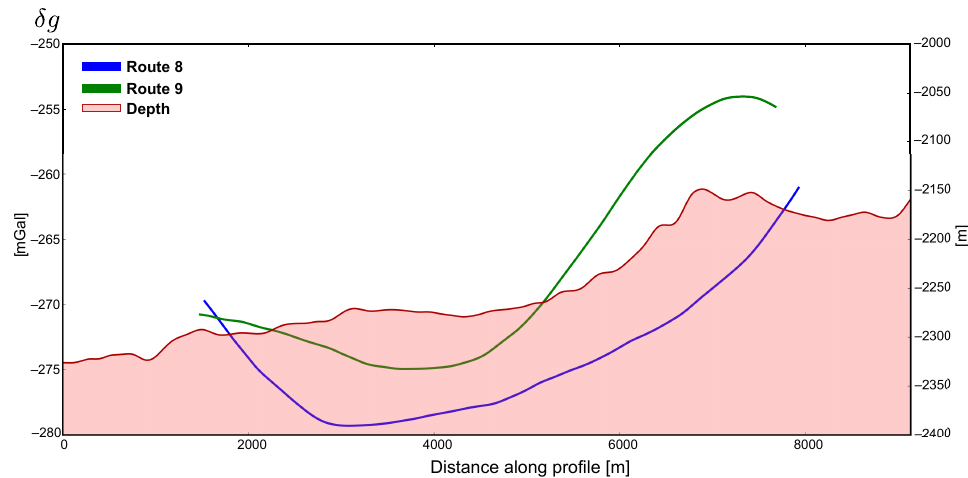
Figure 13. Variations of gravity anomaly δ g on routes 8 (blue solid curve) and 9 (green solid curve) respectively, calculated from the gravity vector intensity (cid:107) g n (cid:107) once high-frequency variations were smoothed out using a 3000 m moving window filter.